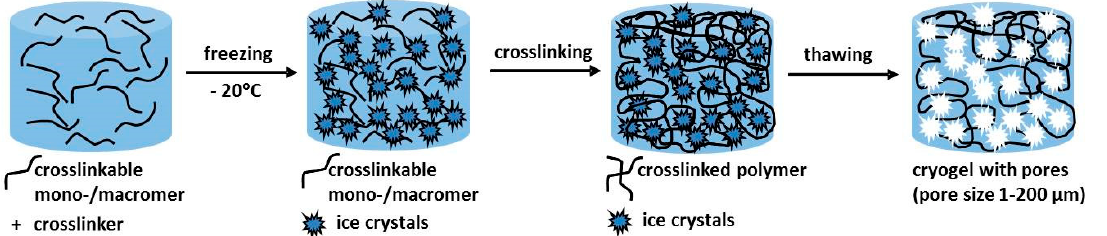
Figure 1. General scheme of the cryogelling process.